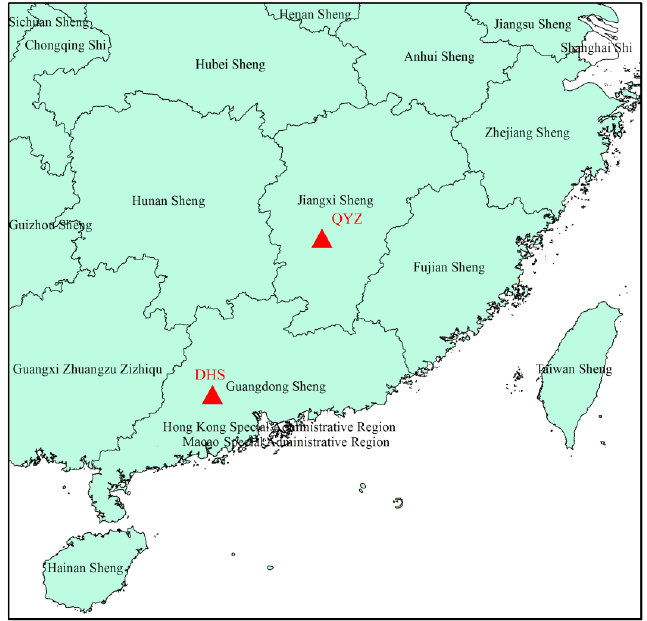
Figure 1. Locations of study sites (indicated by the triangle). DHS, Dinghushan; QYZ, Qianyanzhou.